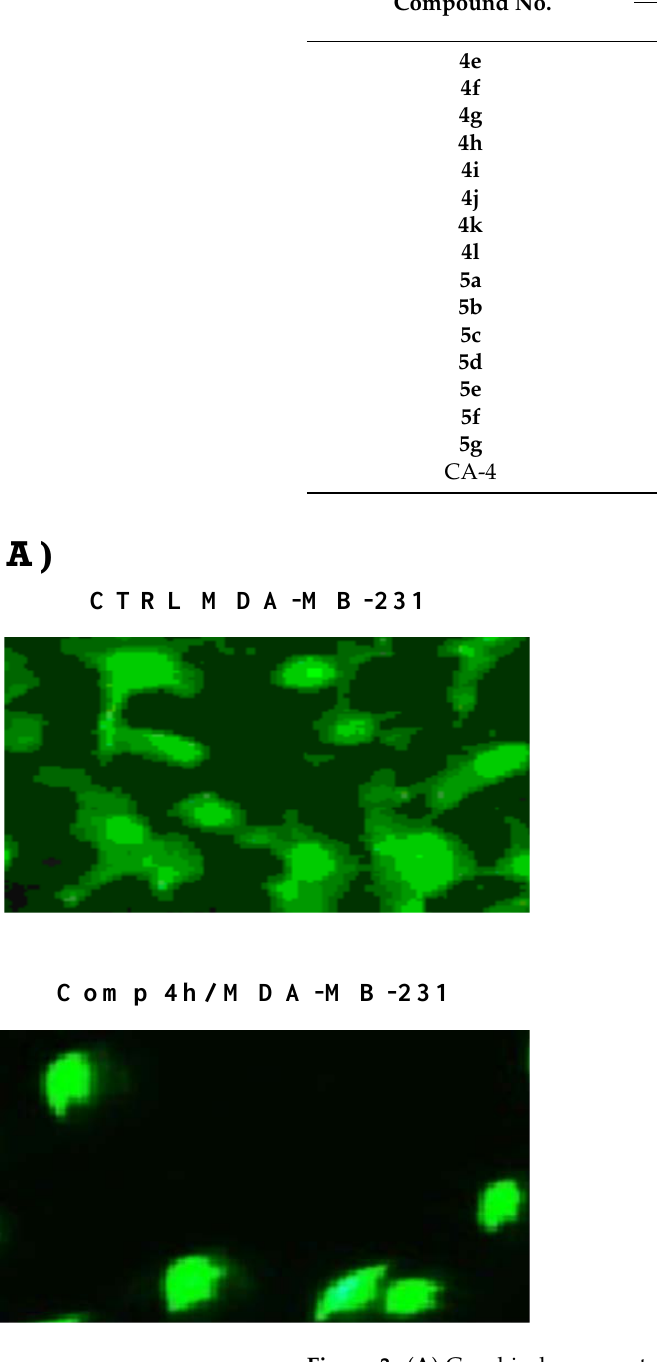
Figure 3. ( A ) Graphical representation of immunofluorescence analysis of tubulin localization in MDA-MB-231 cells after treatment with compound 4h at its IC 50 concentration compared with no treatment control. ( B ) Graphical representation of tubulin concentration (ng/mL) before and after treatment with compound 4h . All values are presented as mean value ± SD and statistical analyses were carried out using one-way analysis of variance (ANOVA) followed by Tukey’s multiple comparison test (*** p < 0.001).